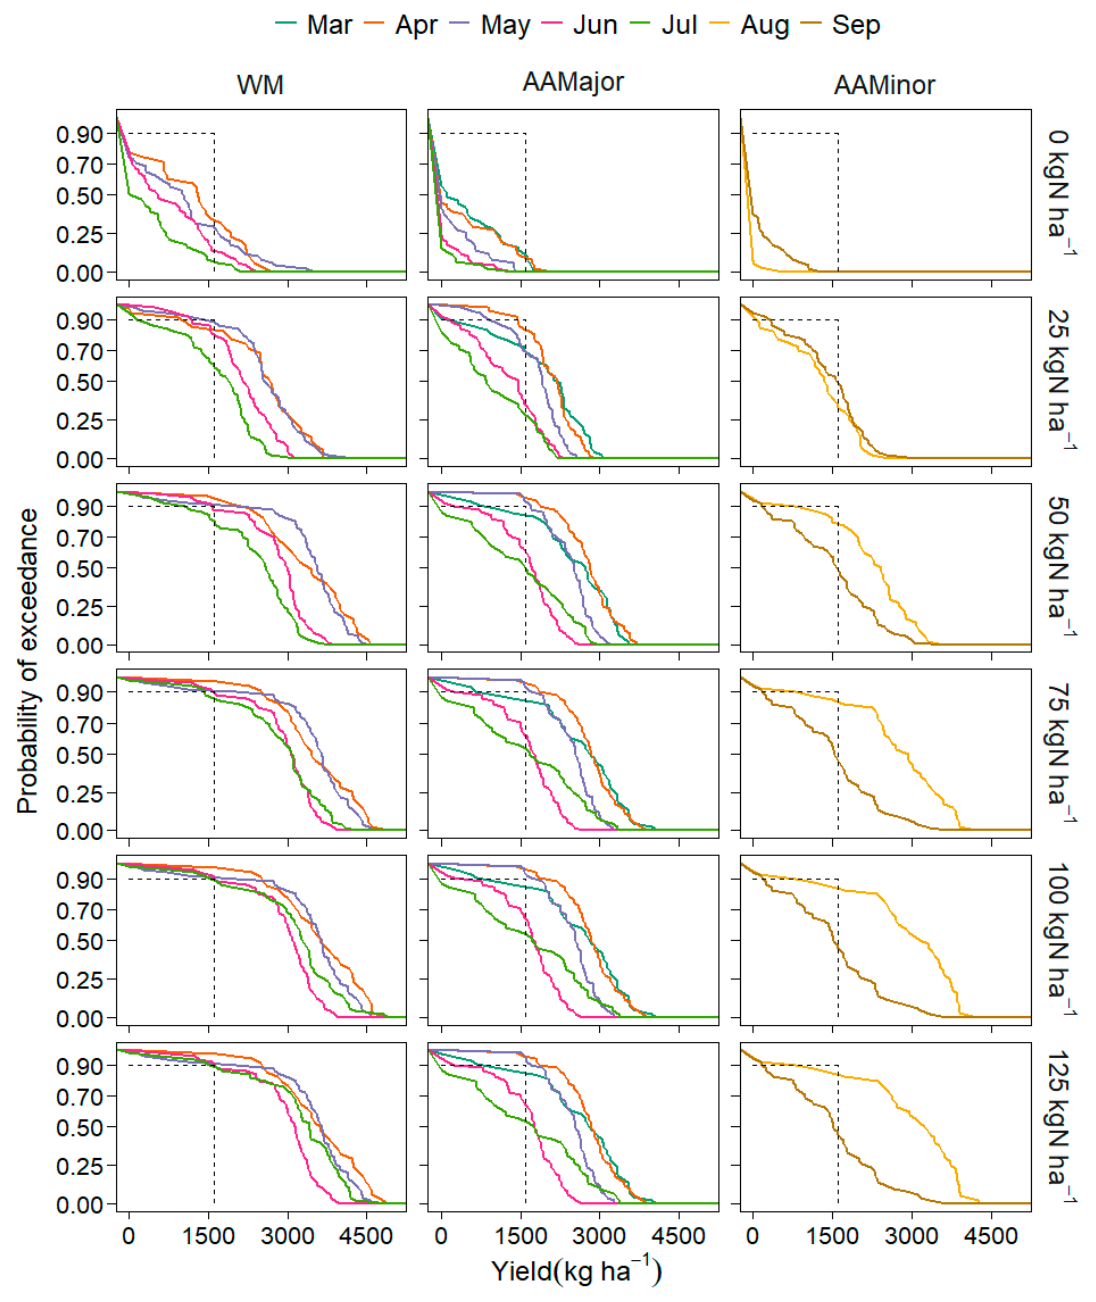
Figure 6. Simulated grain yield under 6 N rates, unconstrained root depth (reaches 1.20 m) and various sowing windows for West Mamprusi (WM), major season Atebubu-Amantin (AAMajor) and minor season Atebubu-Amantin (AAMinor). The vertical broken line at 1600 kg ha − 1 denotes average observed farmers’ yield for all the sites. The horizontal broken line represents the 90% probability that observed farmers’ yield will be equaled or exceeded.